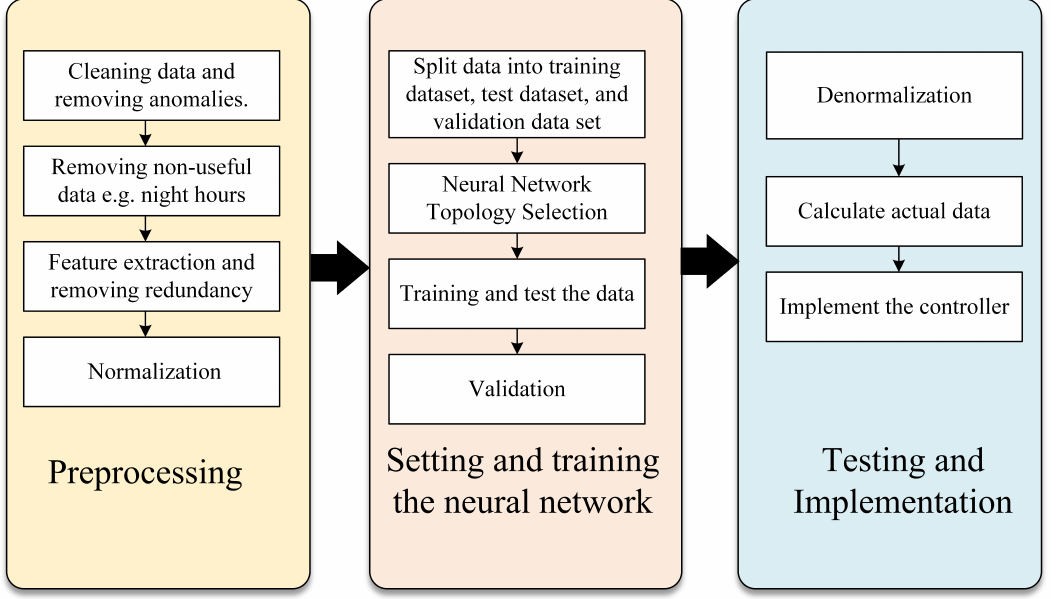
Figure 8. Stages for implementing the neural network based FOC controller. The implementation process has three stages; preprocessing, setting and training the neural network, and testing and